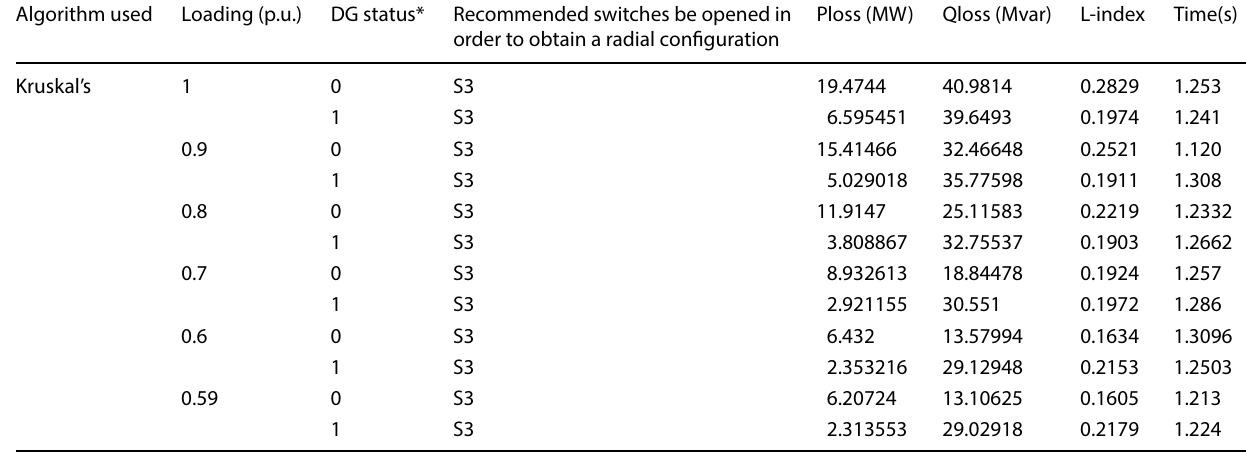
*Where, 0 = network without DG, and 1 = network with